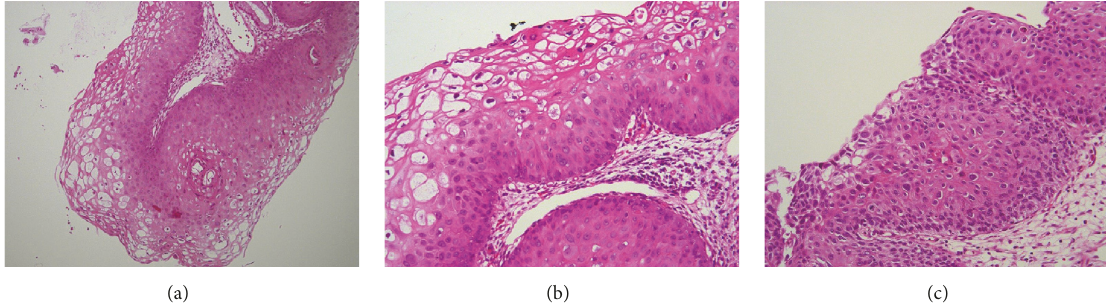
Figure 2: Histopathology images from the punch biopsies. (a) Mild atypia (CIN1) in lower third of cervix squamous epithelium with viral cytopathic effect in upper two-thirds (HE × 100). (b) Higher magnification (HE × 200) of CIN1 showing viral cytopathic effect in upper layers of squamous epithelium and mild atypia in lower third. (c) CIN2, showing almost full thickness epithelial atypia (HE ×